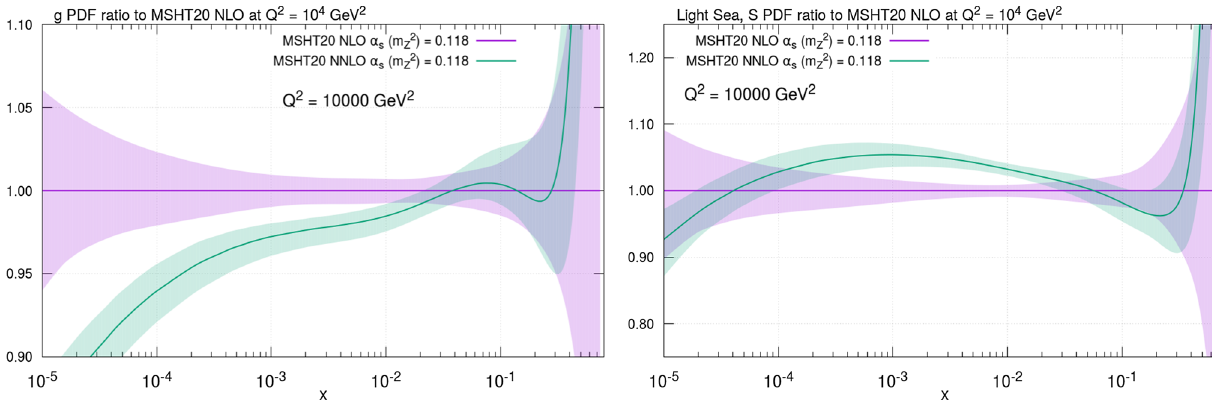
Fig. 37 (Left) Gluon and (right) Light sea PDFs showing the ratio of the MSHT20 PDFs to their NLO values, at Q 2 = 10 4 GeV